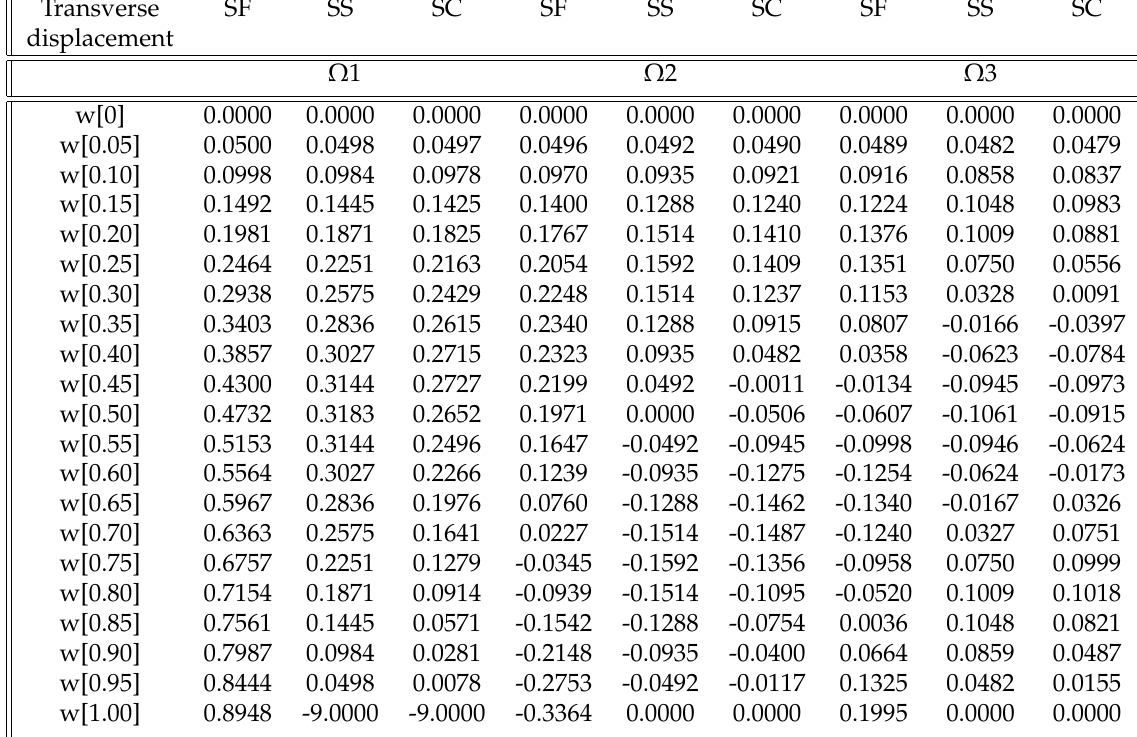
Table 3. Results of different deflection values